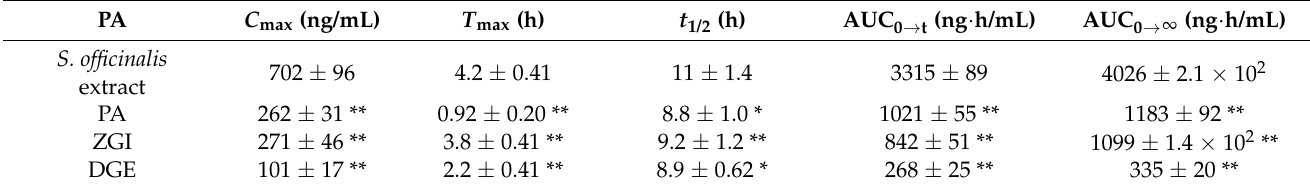
Table 7. Mean plasma concentration–time curve of PA between the extract, pure PA, pure ZGI, and pure DGE. ( n = 6) (Compared with S. officinalis extract * p < 0.05; ** p <